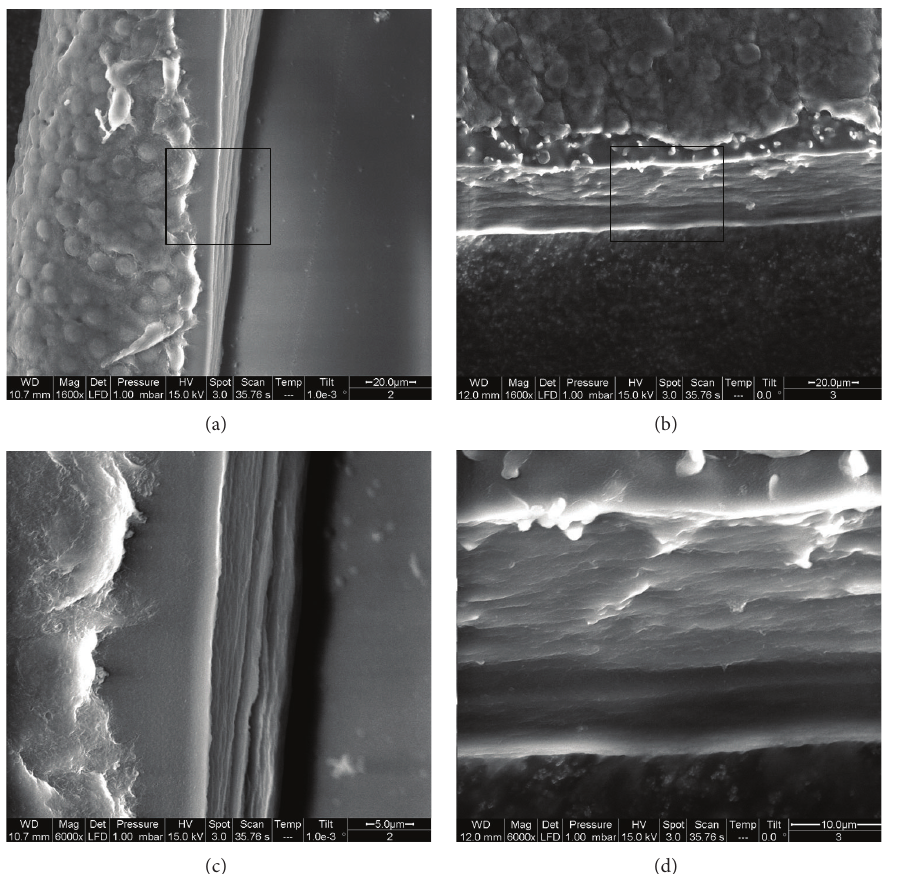
Figure 4: (a), (b) Two manually torn capsules are shown. The stacks of collagen fibers are clearly shown at the edge of the capsule. The edge morphology is smooth, with no irregularity. (c), (d) High-magnification images of the manual CCC edges are shown in (a) and (b),